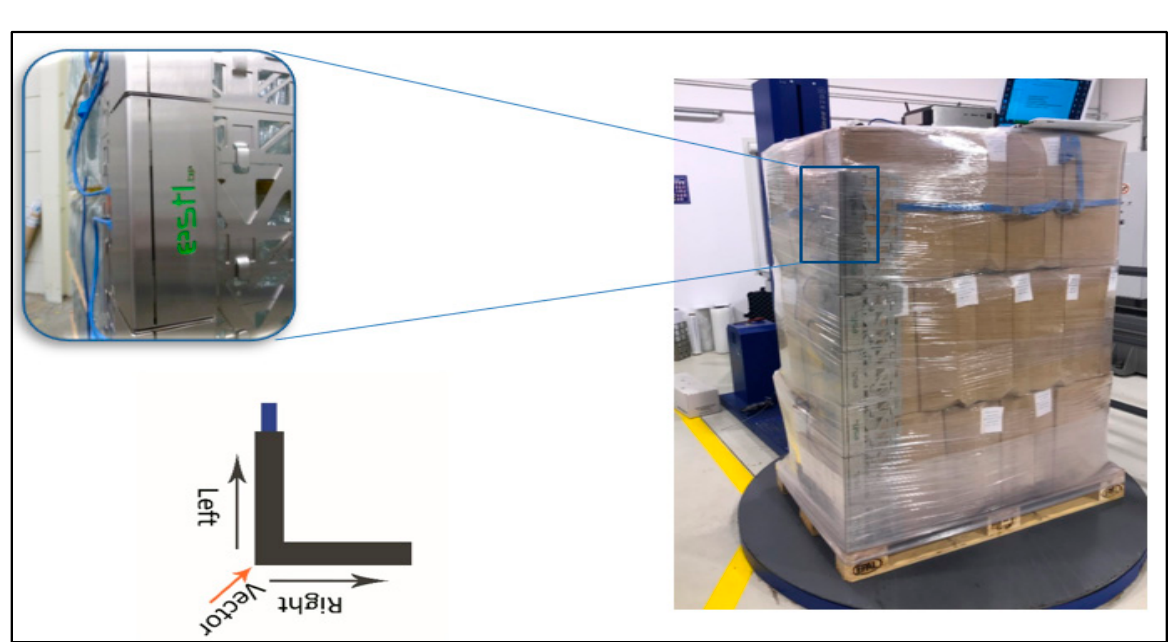
Figure 6. Sensor arrangement FEF-200 on the cargo prepared for testing.